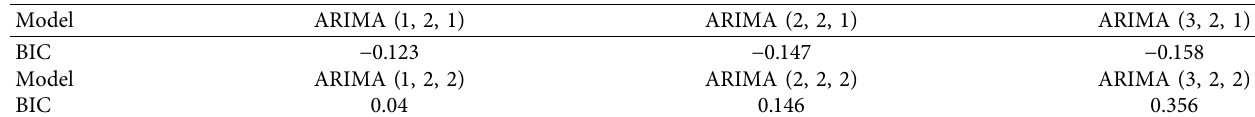
Figure 4: The Auto Correlation Function (ACF) and Partial Auto Correlation Function (PACF) of the average groundwater depth after twice differencing processes. Table 2: The values of BIC of ARIMA models.